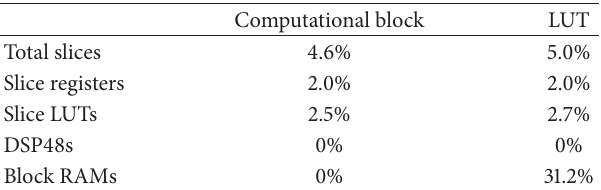
Table2:FPGAgateutilizationforsineandcosinecalculationsusing a LUT or a computational